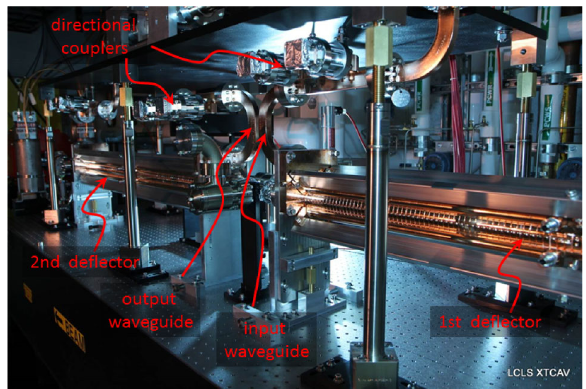
FIG. 11. A photo of the X -band rf deflector system installed in the undulator beam line. (Picture credit: P.